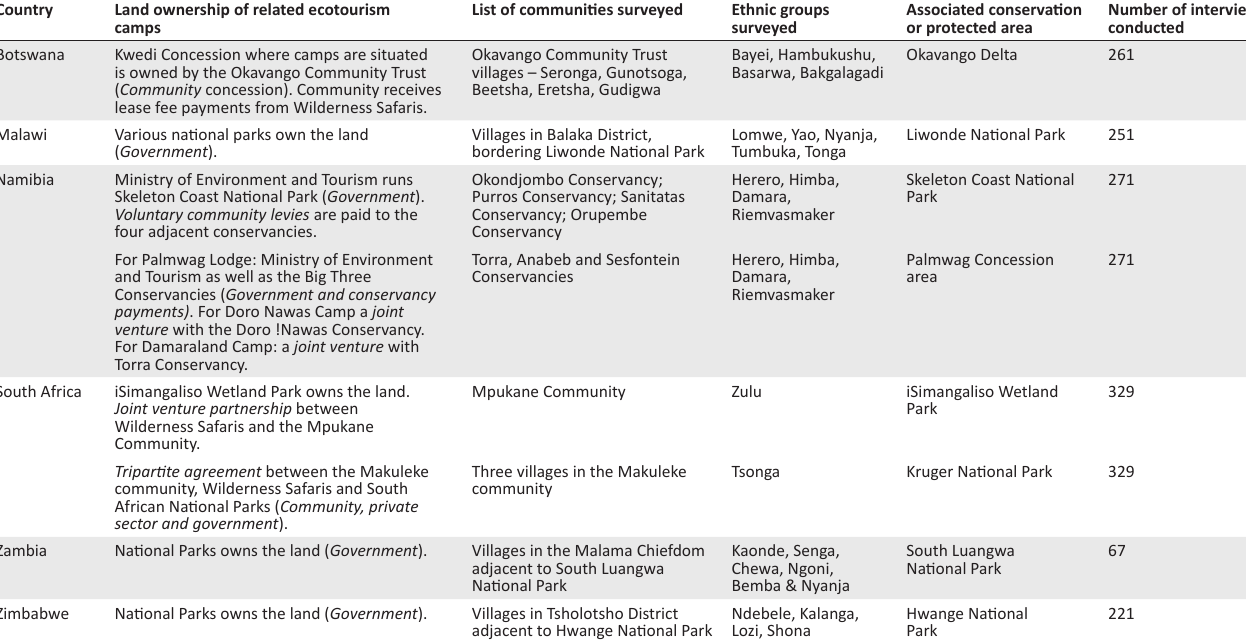
TABLE 1: Details of communities surveyed in each country. Country Land ownership of related ecotourism